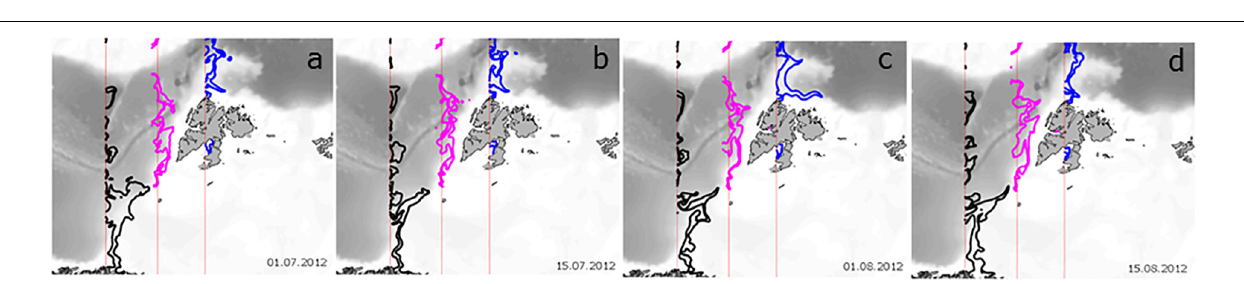
FIGURE 5 | Persistence of summer phytoplankton biomass along the Atlantic Water Inflow after GPP is turned off. The three locations are depicted with the vertical red lines (see also orange transect lines in Figure 1b ). The thick lines depict the locations where 20% of the initial biomass is retained, after GPP = 0, from the NW Norway (black), Barents Opening (pink) and NW Svalbard (blue) for (a) 1 July, (b) 15 July, (c) 1 August and (d) 15 August